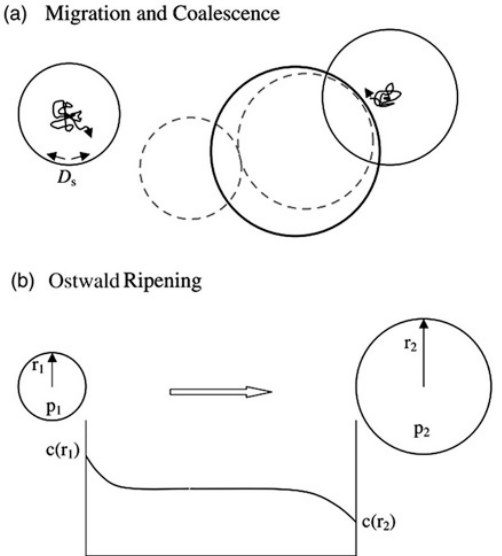
Figure 3. Schematic illustration of the two main bubble coarsening mechanisms, ( a ) migration and coalescence via surface diffusion, ( b ) Ostwald ripening due to He fluxes driven by differences in the thermal equilibrium He concentrations in the vicinity of small and large bubbles [8].